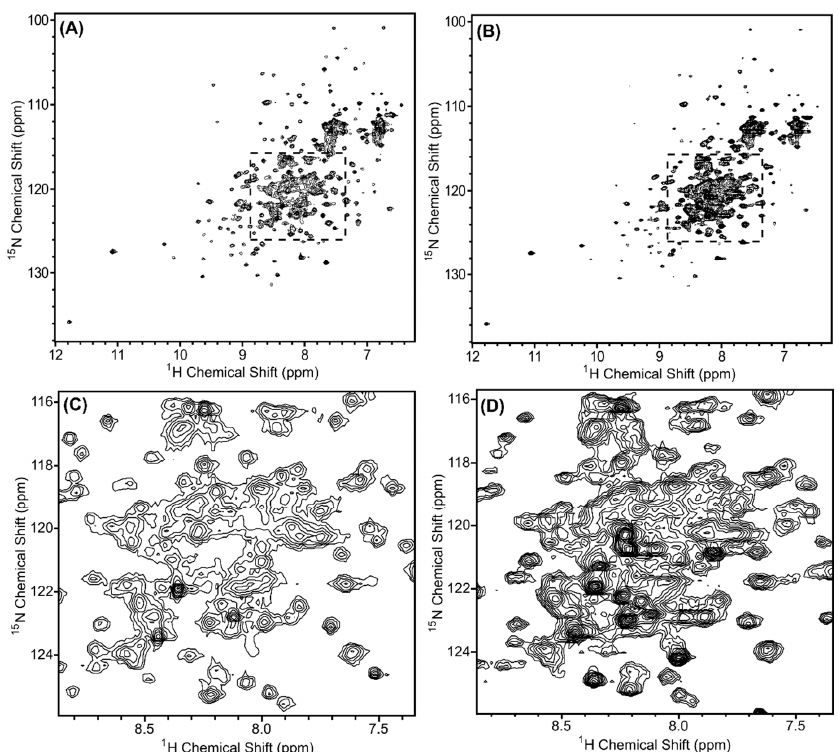
Figure 2. 1 H- 15 N HSQC spectra of the in vivo-associated, 15 N-labeled protein complexes ( A , C ) Scc4:His 6 -Scc1 and ( B , D ) His 6 -Scc4:Scc1-FLAG. The regions shown in ( C ) and ( D ) are expanded from the dashed boxes shown in ( A ) and ( B ). The complexes were 0.35 mM concentration in 50 mM sodium phosphate, 10 mM of DTT, pH 7.3 buffer, and the spectra were collected with 32 scans using a Bruker AVIII 500 MHz spectrometer. Overlays of the spectra are shown in Figure